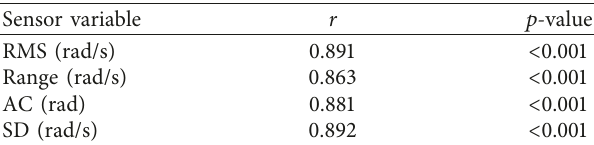
Table 1: Spearmen’s rho correlation coefficient of inertial sensor variables compared with the COP path derived from a force